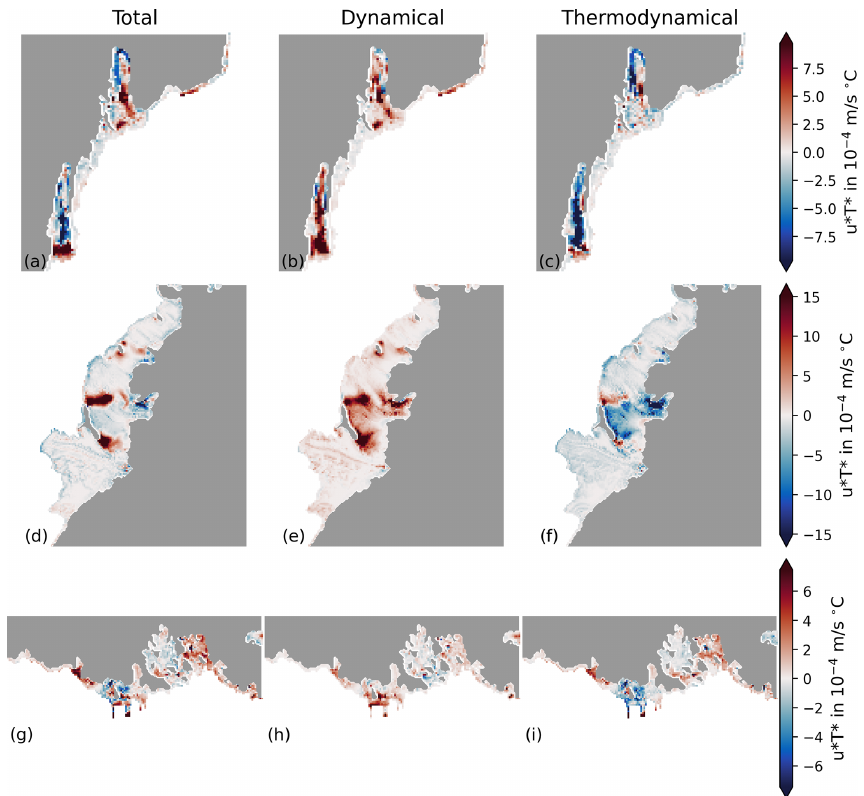
Figure B2. Dynamical–thermodynamical decomposition of tidal melting under the Totten–Moscow University ice shelf system (a–c) , Riiser- Larsen Ice Shelf (d–f) and the ice shelves of the eastern Ross Sea ( g–i ; see Sect. 2.3).